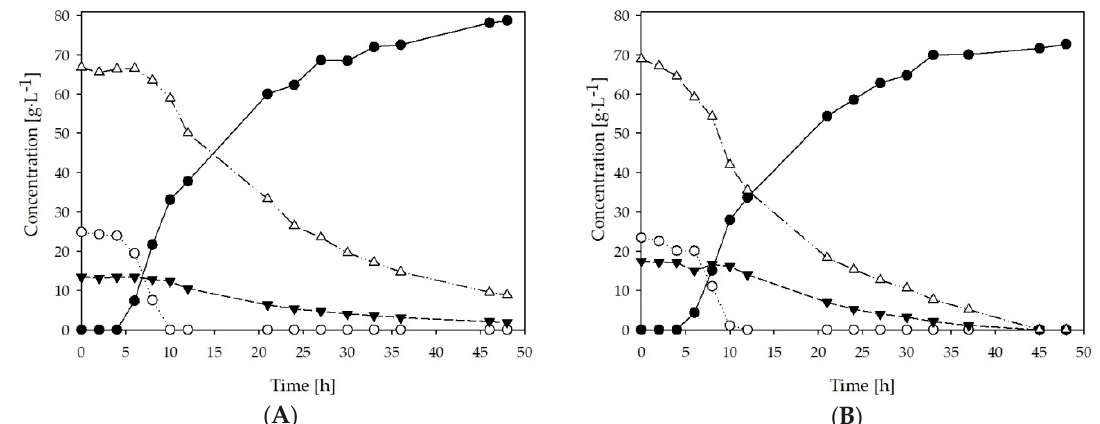
Figure 2. Fermentative production of lactic acid ( ● ) and consumption of glucose ( ○ ); fructose ▼ ; disaccharides ( ∆ ) by B.coagulans in two different batches ( A , B ) of SSJ.